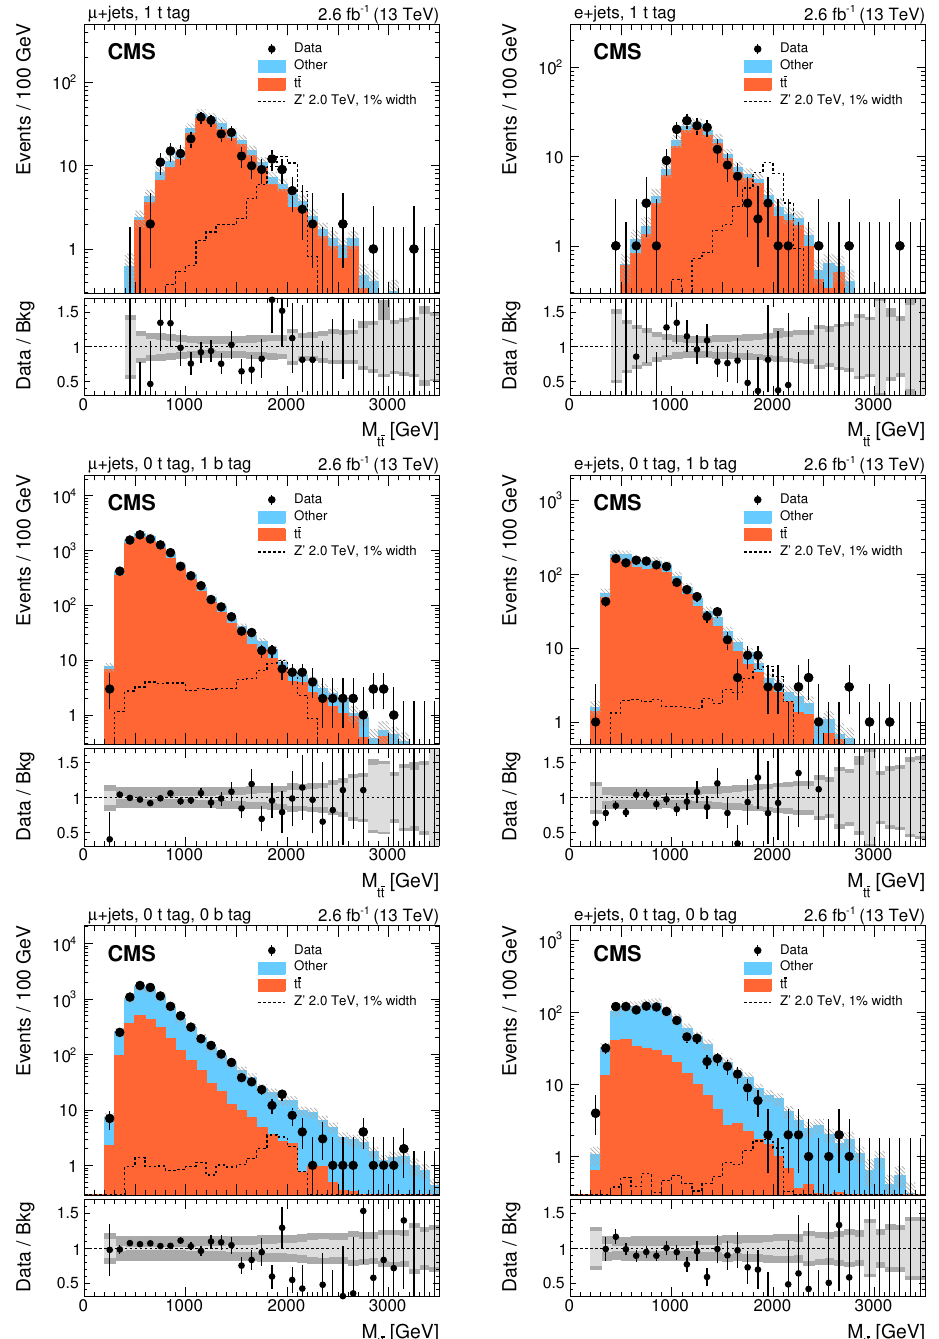
Figure 4 . Distributions in M for data and expected background, for events passing the signal tt selection of the lepton+jets analysis ( (cid:31) 2 < 30) after the maximum likelihood (cid:12)t. Distributions are shown for the muon (left) and electron (right) channel. For each lepton (cid:13)avor, events are split into three exclusive categories (from uppermost to lowest): (1 t tag), (0 t tag ; 1 b tag), and (0 t tag ; 0 b tag). The signal templates are normalized to a cross section of 1 pb. The uncertainties associated with the background expectation include the statistical and all post-(cid:12)t systematic un- certainties. The lower panel in each (cid:12)gure shows the ratio of data to predicted SM background, with the statistical (light gray) and total (dark gray) uncertainties shown separately.